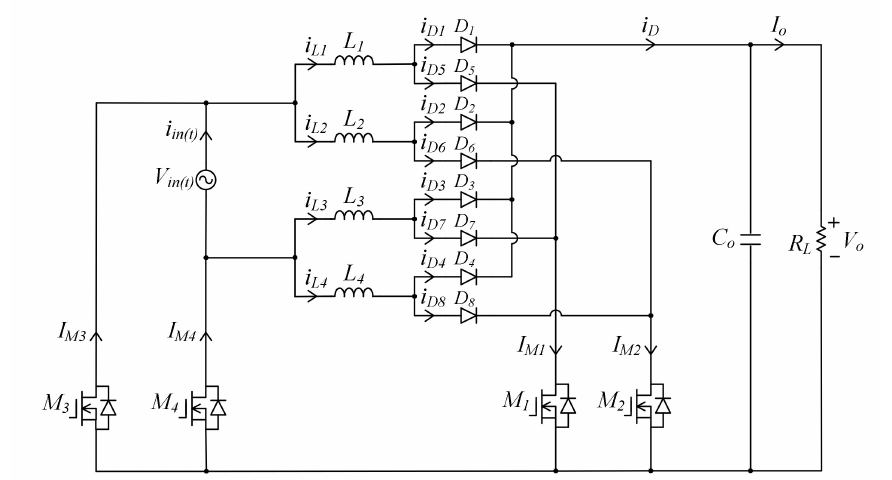
Figure 6. Schematic diagram of the proposed interleaving bridgeless boost converter. Table 1. Performance comparison among different PFCs with power flow through component paths.